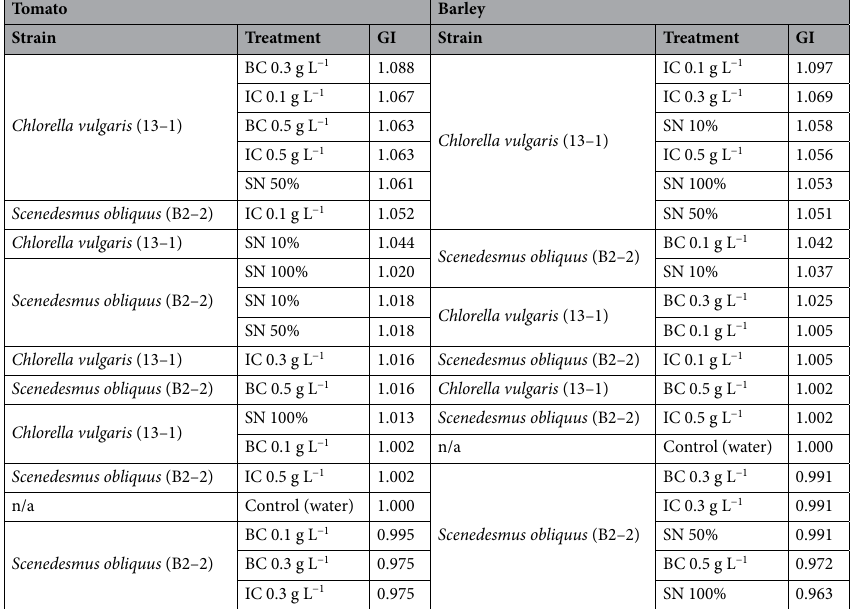
Table 1. Germination index (GI) in tomato and barley seeds under the different treatments. GI values were calculated from the 100 seeds in each treatment and expressed relative to the value of the control group (water). Treatments are sorted within each seed type, from highest to lowest GI. Treatment name is given in the format ‘strain’ ‘cell type’ concentration’, where 13–1: C. vulgaris , B2-2: S. obliquus 27 IC: intact cells; BC: broken cells; SN: supernatant. See Section “Materials and methods” for full details on how each treatment was produced.